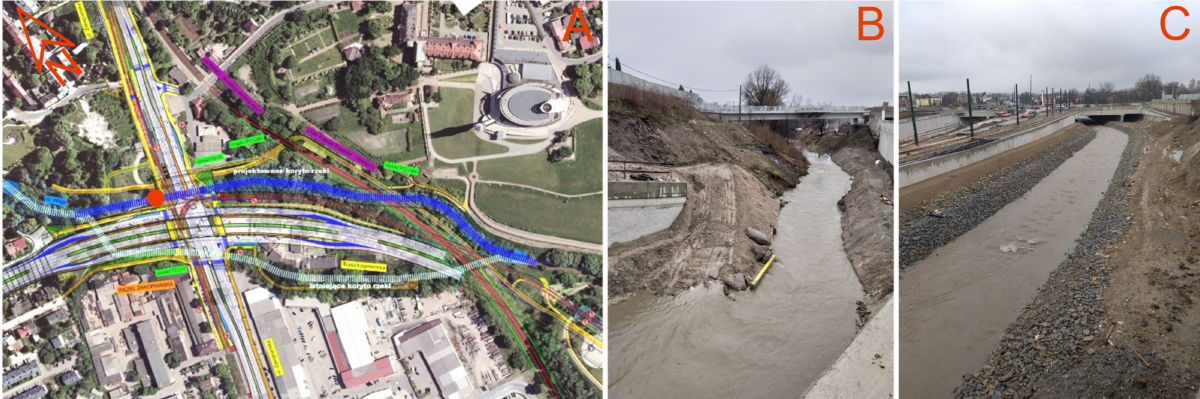
Figure 2. Relocated section of the Wilga River: ( A )—photomap with the indication of the old river bed (light blue) and new river bed (dark blue) (obtained courtesy of Trasa Łagiewnicka S.A. [59]), as well as the location of sampling point No. 6 (red dot); ( B )—section of old river bed seen from the vicinity of sampling point No. 6; ( C )—section of new river bed seen from the vicinity of sampling point No. 6 (Figure